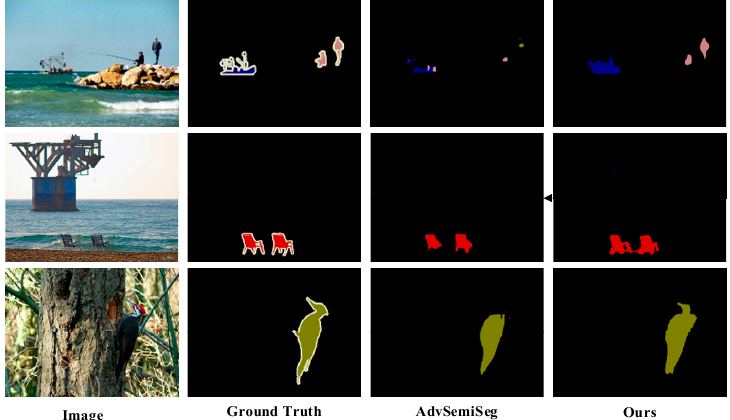
Figure 8. The experimental effect images of the VOC dataset. Table 5. Comparison of AdvSemiSeg methods and our method for segmentation on the VOC 2012 dataset.